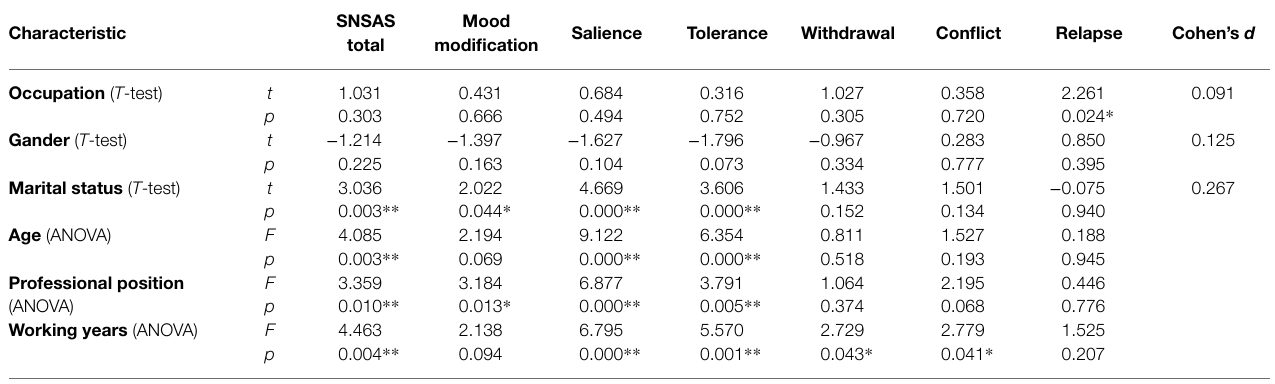
TABLE 5 | Results of t -test and analysis of variance of SNSAS score.